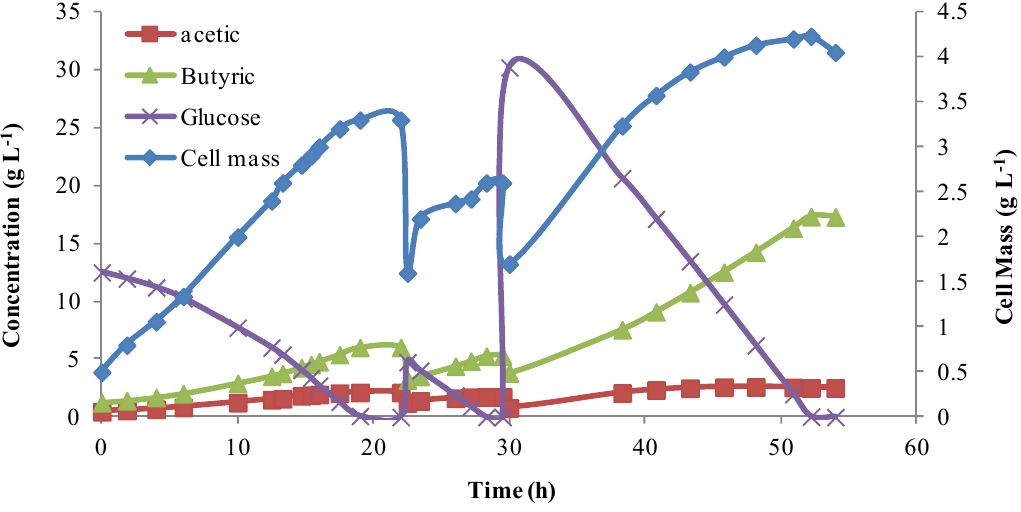
Figure 1. Kinetics of batch fermentation of glucose by Clostridium tyrobutyricum producing butyric acid and acetic acid at pH 6.2 in PYG